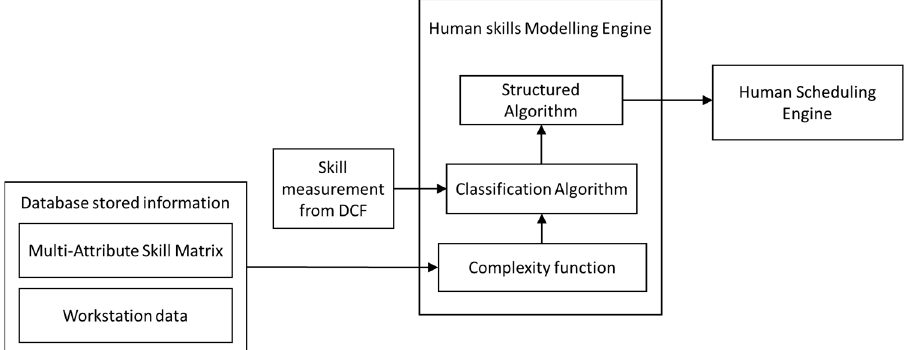
Figure 4. Human skills modeling engine.